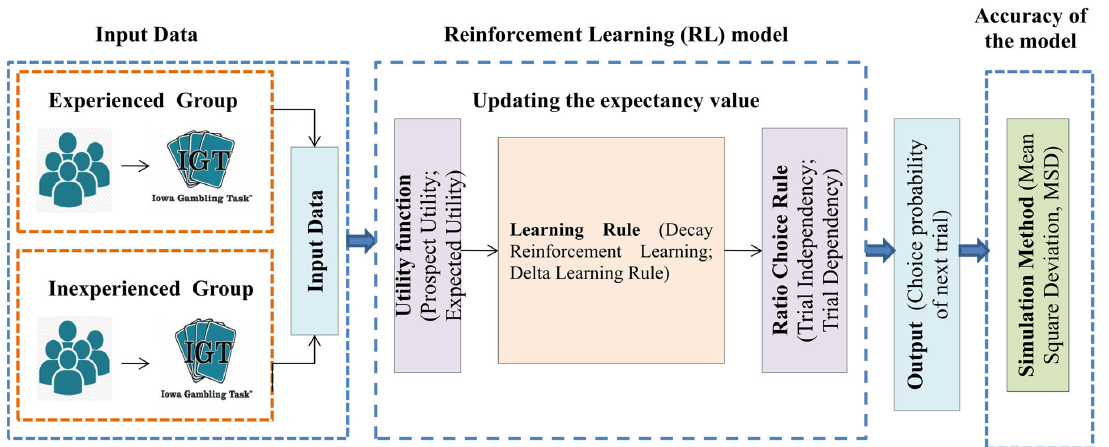
Fig. 1. The flow diagram of experienced-based Decision-Making model